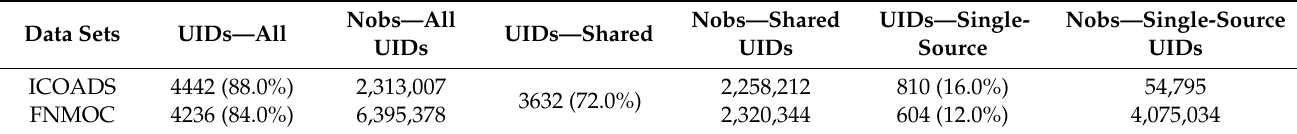
Table 3. The numbers of ship UIDs and Nobs in ICOADS and FNMOC for all, shared, and single-source UIDs. Values in parentheses are the percentages against total UIDs (N = 5046 = 100%). Data Sets